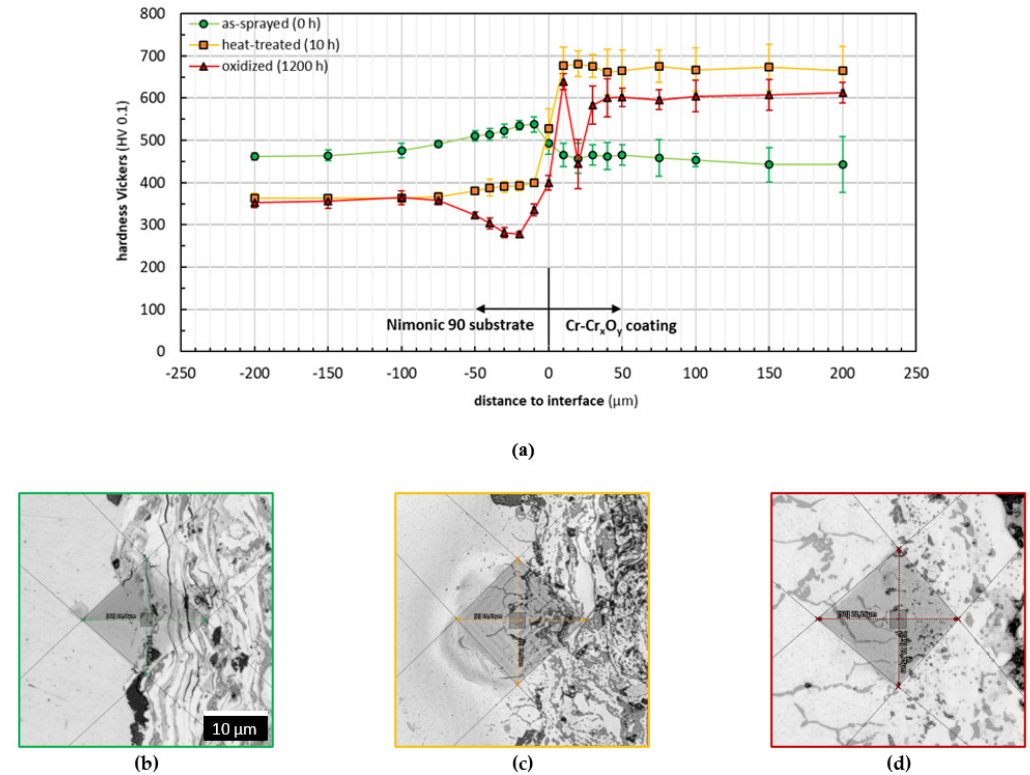
Figure 9. Evaluation of materials microhardness perpendicular to the interface substrate/Cr-Cr x O y coatings: ( a ) Vickers microhardness profiles and corresponding cross-section CLSM micrographs of exemplary indents at the interface substrate/Cr-Cr x O y coatings: ( b ) as-sprayed (green framed), ( c ) heat-treated (orange framed), and ( d ) isothermally oxidized (red framed).